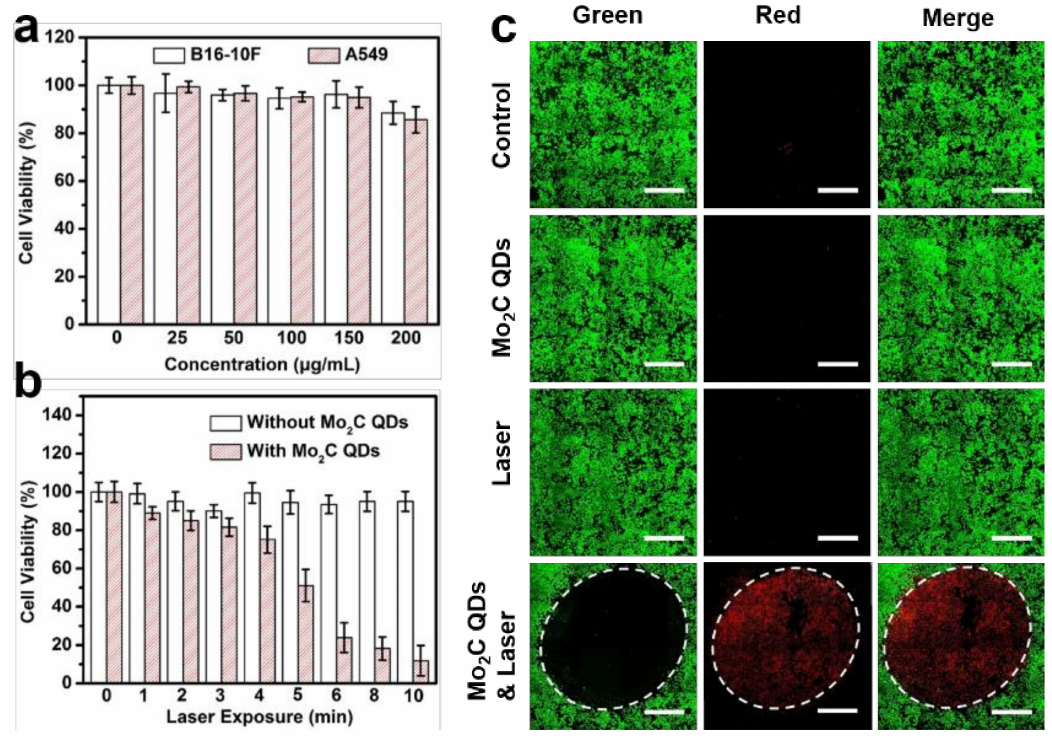
Figure 4. ( a ) Cell viabilities of B16-10F and A549 cells incubated with Mo 2 C QDs at different concentrations for 24 h; ( b ) Cell viabilities of B16-10F cells incubated with or without Mo 2 C QDs under an 808 nm laser (0.64 W/cm 2 ) irradiation for different times; ( c ) Confocal images of calcein AM/PI-costained B16-10F cells incubated with or without Mo 2 C QDs and treated with or without an 808 nm laser (0.64 W/cm 2 ) for 10 min. Scale bars: 1